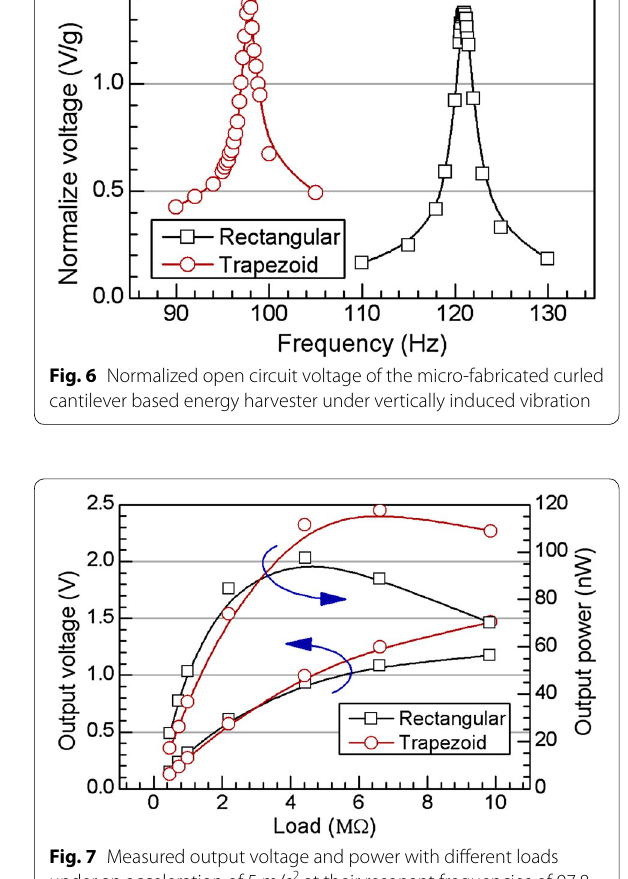
Fig. 6. Maximum output powers of 117 and 97 nW were